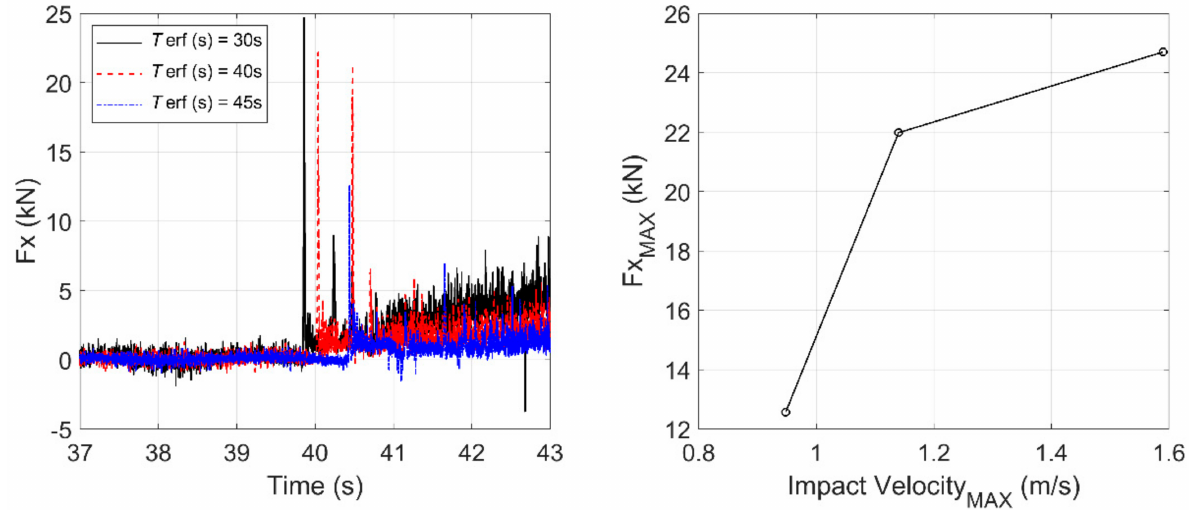
Figure 15. Free − debris histories ( left ) and maximum values of debris impact on the column vs. the impact velocity ( right ). Numerical results for h 1 = 2.496 m h 2 = 0.13 m, and T erf = 30, 40, and 45